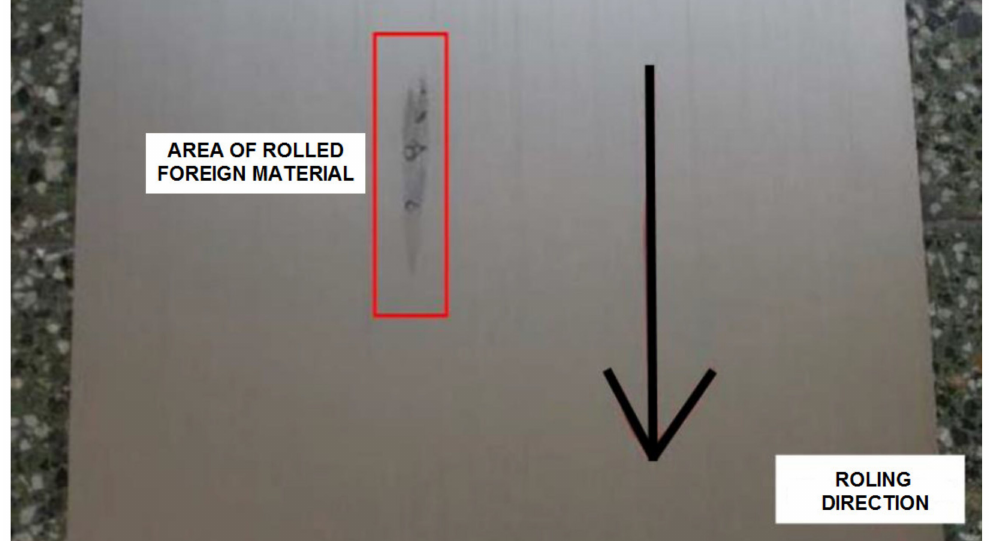
Figure 1. Occurrence of a strip error. Source: own